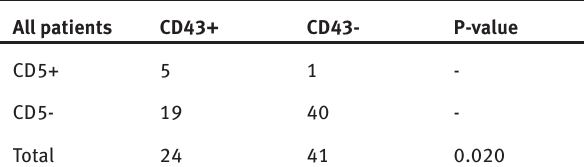
Table 2: Expression of CD5 and CD43 in diffuse large B-cell lym- phoma (n =